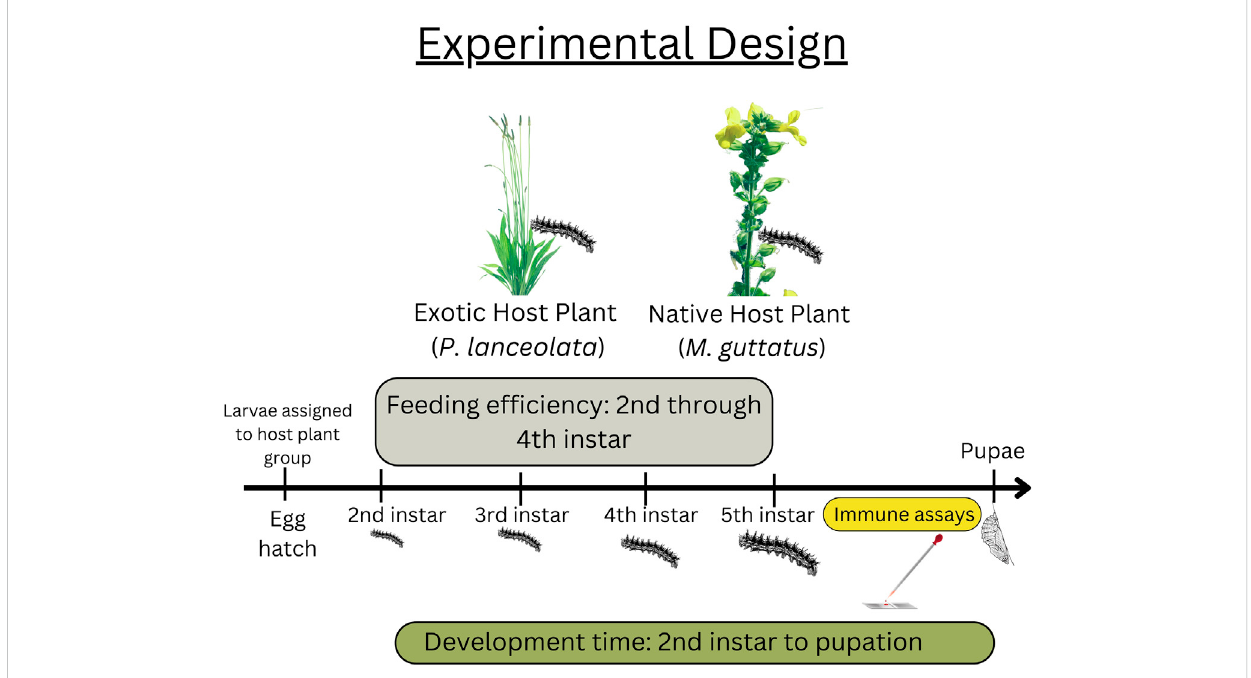
FIGURE 1 Experimentaldesignincludingdatacollectiontimepoints.Feedingef fi ciencytookplacebetweenthesecondandfourthinstars.Datafortheimmune assays were collected at the beginning of the fi fth instar. Development time was recorded from the beginning of second instar to pupation